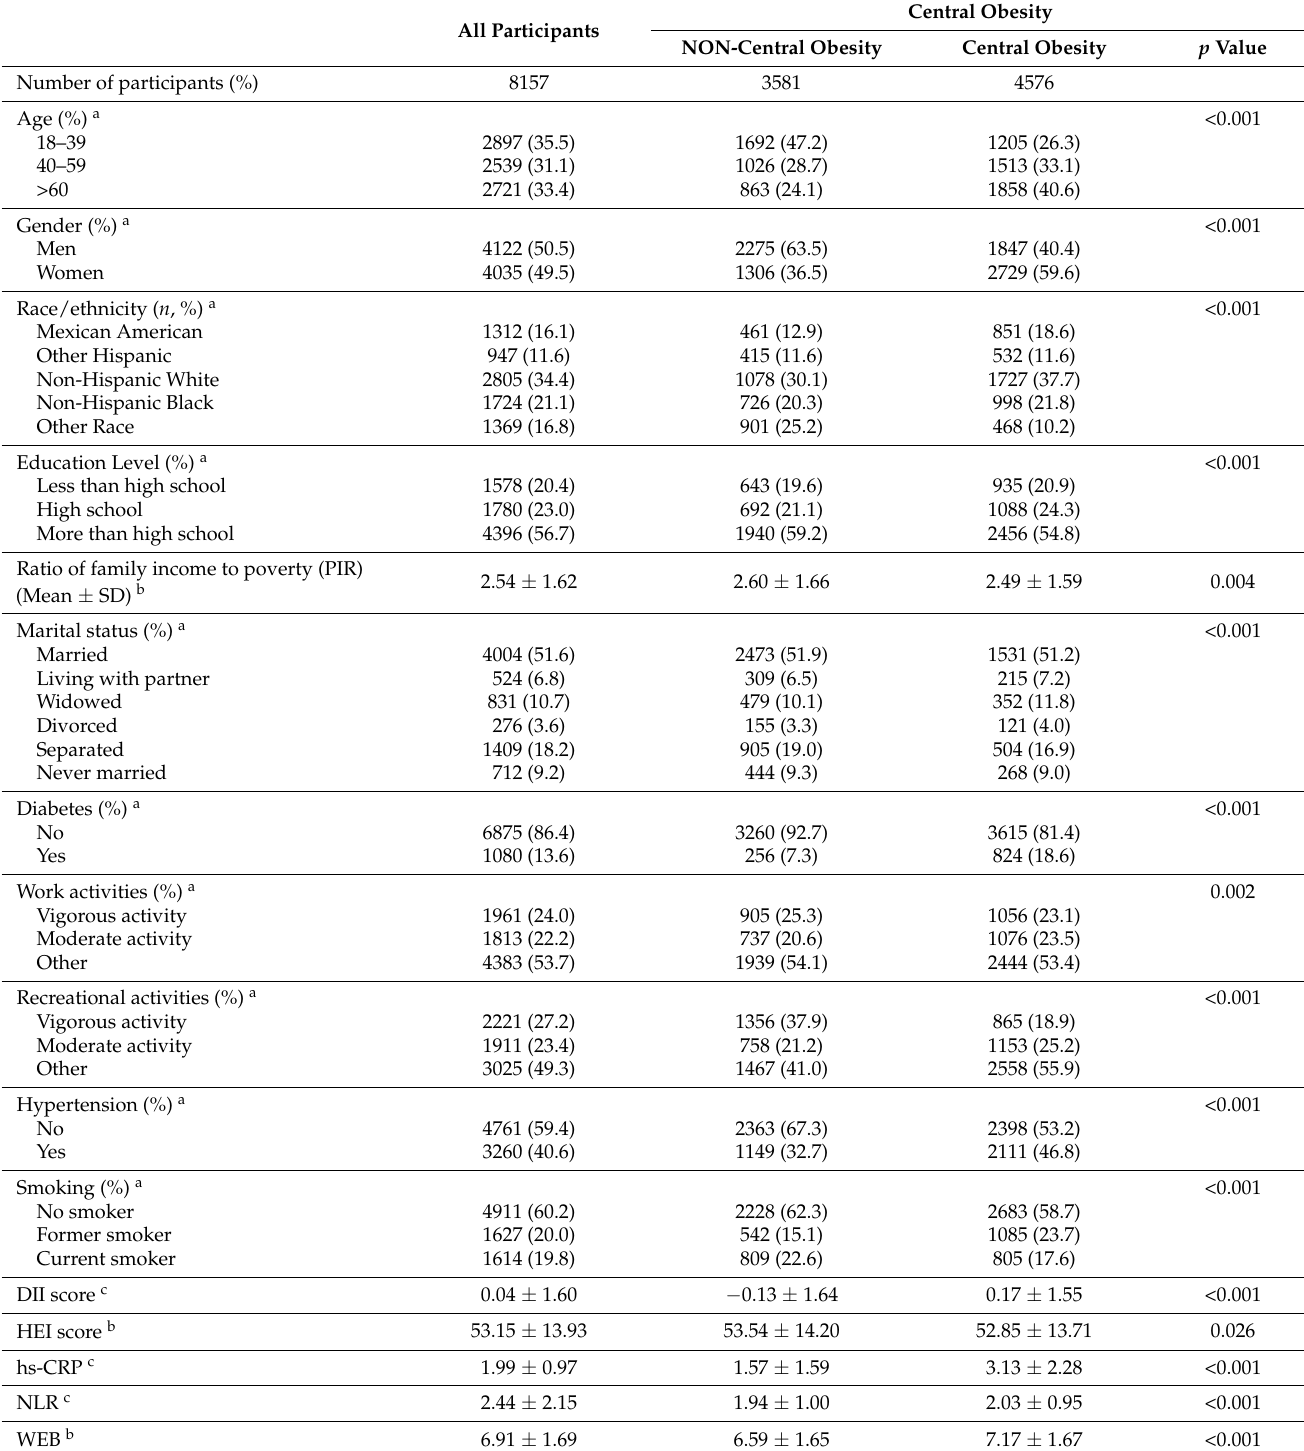
Table 1. Characteristics of participants by central obesity in NHANES 2015–2018 (N =